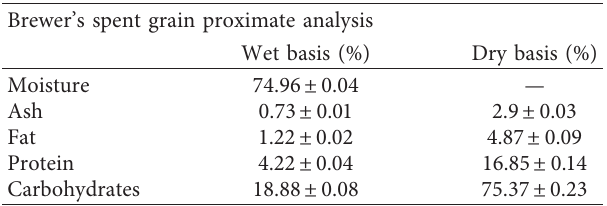
Figure 2: Survey given to panelists to evaluate six different chip formulations. Each response is based on a 5-point hedonic scale. Table 2: Proximate analysis of spent grain from Stilly Wheat Ale (Iron Monk Brewery).